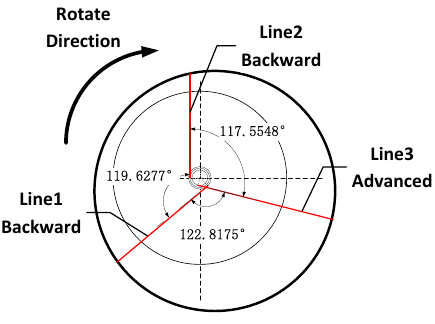
Figure 10. The angle between two adjacent laser beam.